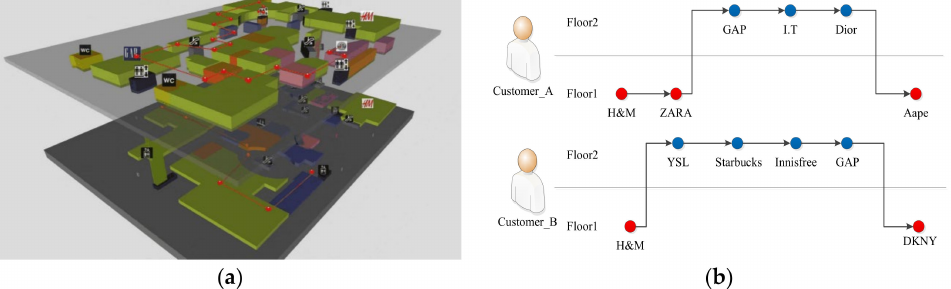
Figure 2. (a ) Schematic diagram of a trajectory in three-dimensional space; ( b ) schematic diagram of POI